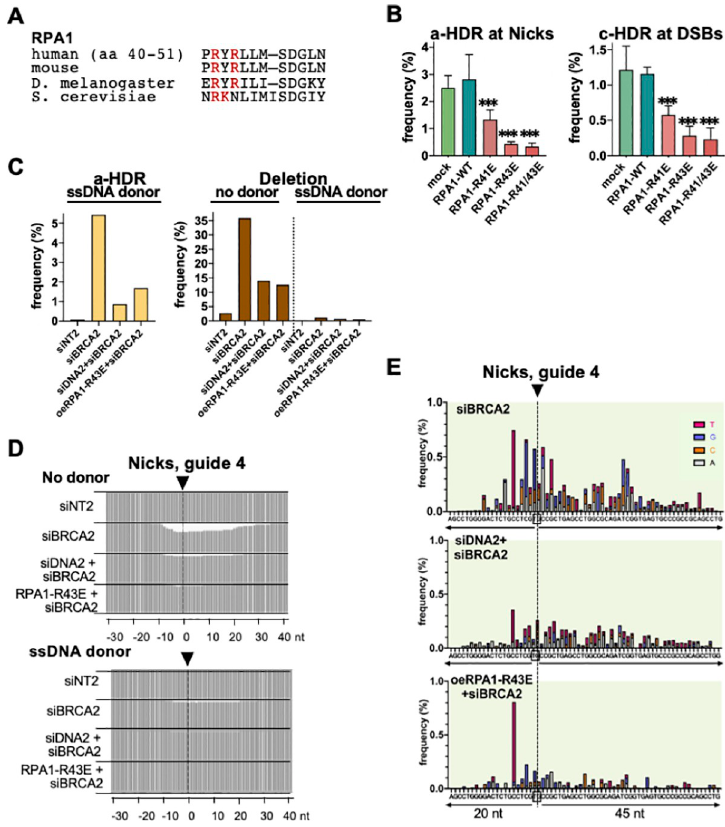
Fig 2. DNA2 and RPA1 promote resection resulting in a-HDR or mutagenesis at nicks. (A) Alignment of RPA1 protein sequences in the conserved N-terminal region to which the S . cerevisiae Rfa1-t11 (K45E) mutation maps [22]. (B) Frequencies of a-HDR at nicks or c-HDR at DSBs as determined by reporter assays in 293 TL cells ectopically expressing RPA1 WT or its mutant derivatives. Frequency values represent the mean ± SEM from a representative experiment; ��� indicates p < 0.001 for the frequency difference between the indicated sample and sample expressing RPA1-WT. (C) Frequencies of a-HDR at nicks targeted to the CD44 gene in U2OS cells ectopically expressing RPA1-WT or its mutant derivatives and provided with a ssDNA donor for a-HDR by sequence analysis. (D) Maps of the fractional decrease in the number of base calls at each position within the indicated region spanning the gRNA 4 cleavage site in U2OS cells in cells treated as indicated and lacking or provided with a ssDNA donor complementary to the nicked strand (cN) to support a-HDR. (E) Maps of positions and spectra of SNVs within the indicated 65 bp region spanning nicks targeted by gRNA 4 to the CD44 gene in U2OS cells treated as indicated. The colored bar represents SNVs at each reference position: A, gray; C, orange; G, blue; T, red.